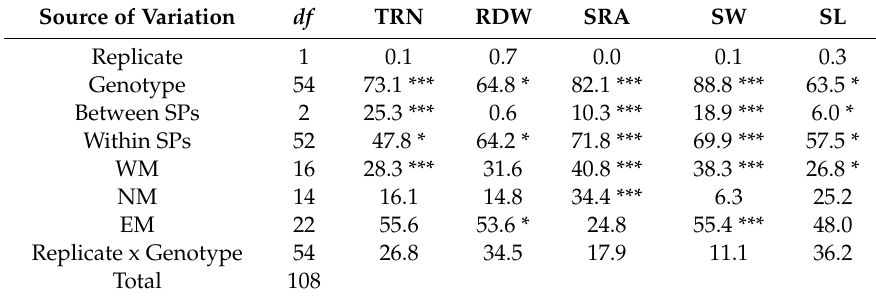
Table 2. Percentage of the sum of squares of the ANOVA in a set of 55 bread wheat landraces structured into three genetic subpopulations with membership coe ffi cient q >